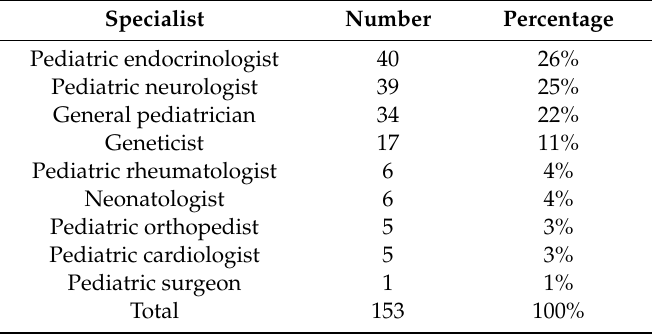
Table 2. Number and percentage of di ff erent specialists who sent the urine sample to our laboratory for at-risk population screening for mucopolysaccharidoses.